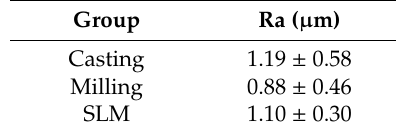
Table 4. Surface roughness of the